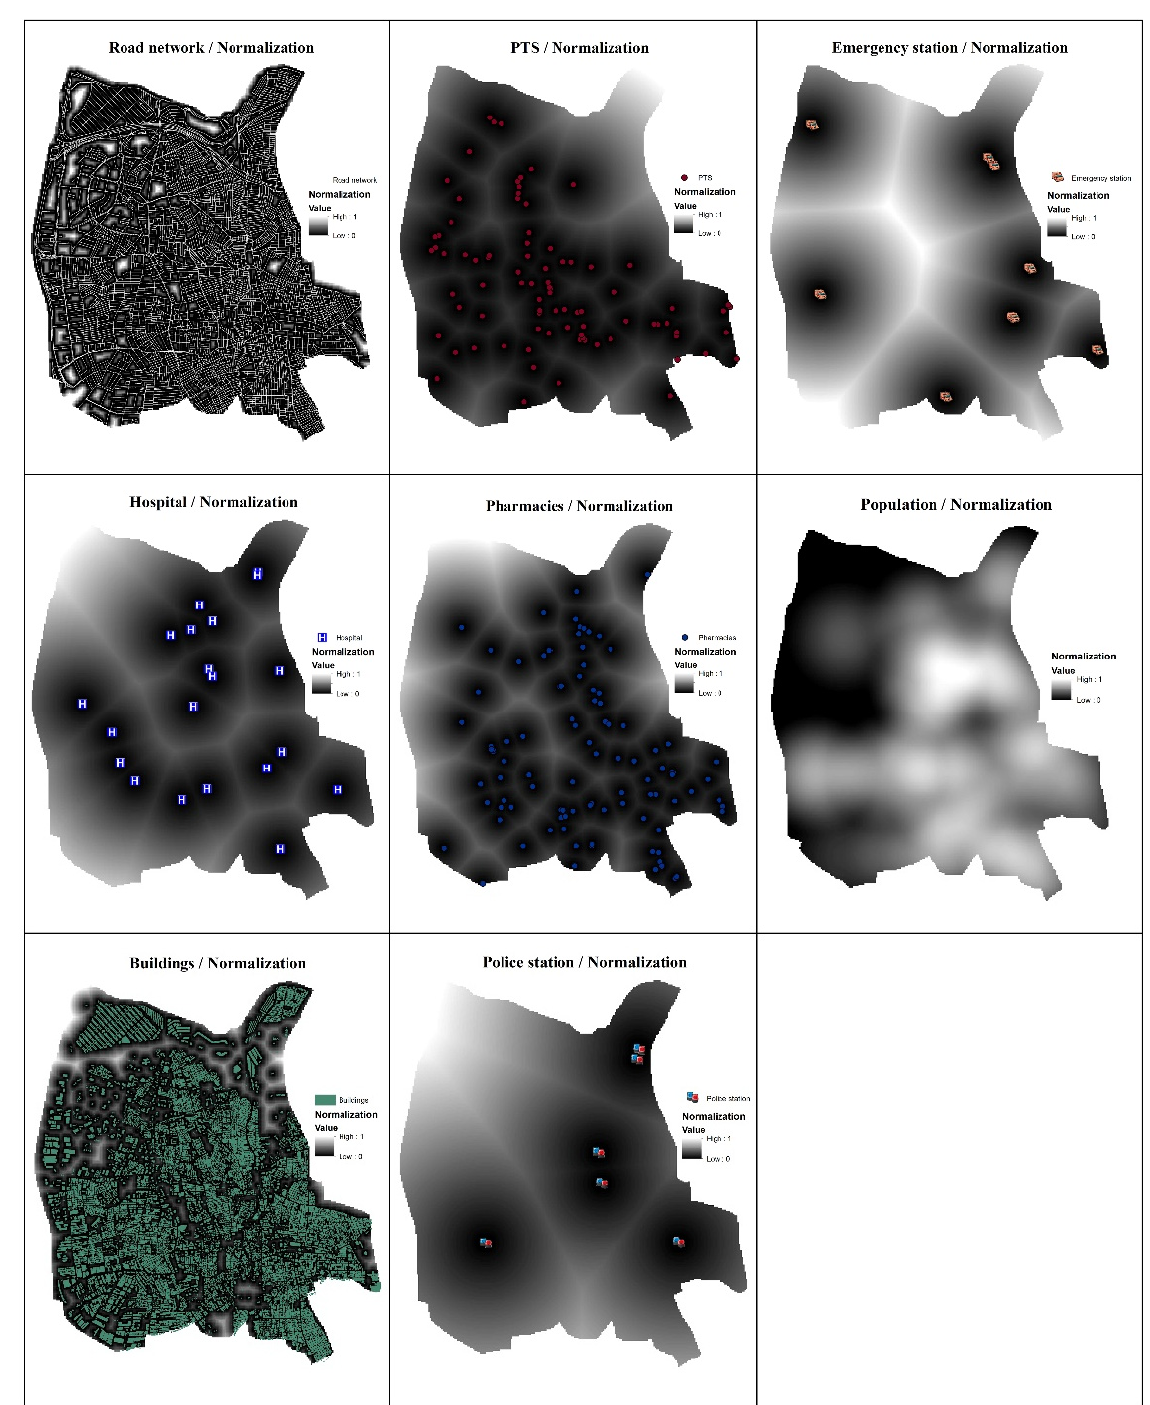
Figure 5. GIS layer of each criteria.